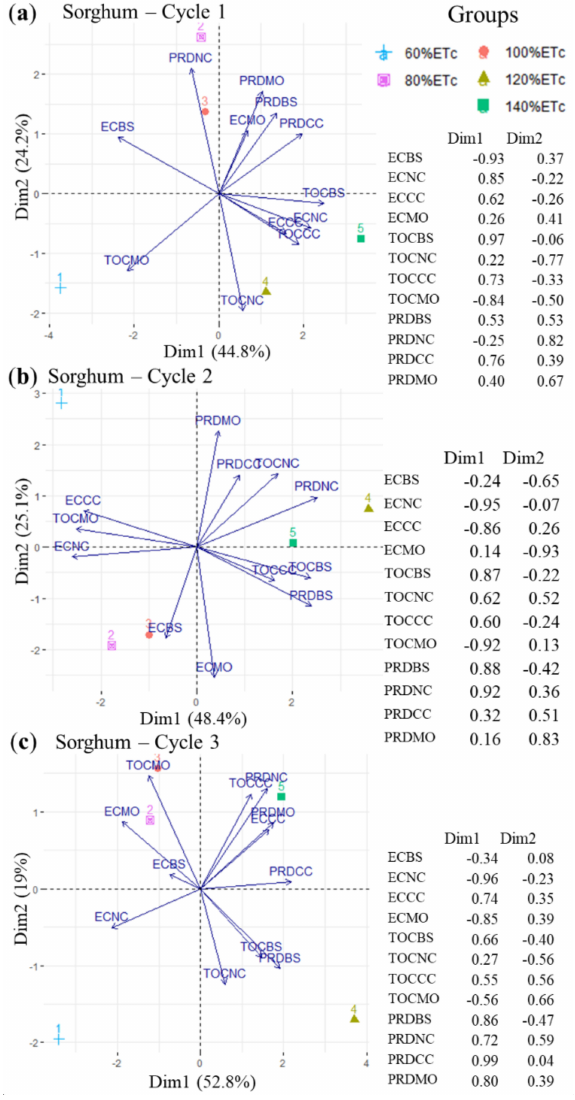
Figure 10. Biplots of multivariate analysis using the principal components 1 (Dim1) and 2 (Dim2) for soil electrical conductivity (EC), total organic carbon (TOC), and productivity (PRD), under different soil cover conditions: bare soil (BS), natural cover (NC), coconut coir (CC) and moringa (MO), for the following combinations: ECBS, ECNC, ECCC, ECMO, TOCBS, TOCNC, TOCCC, MOTMO, TOCMO, PRDBS, PRDNC, PRDCC, and PRDMO, as a function of wastewater irrigation depths (60%, 80%, 100%, 120% and 140% of ETc), and the results of the principal component analysis (PCA) for cycle 1 ( a ), 2 ( b ), and 3 ( c